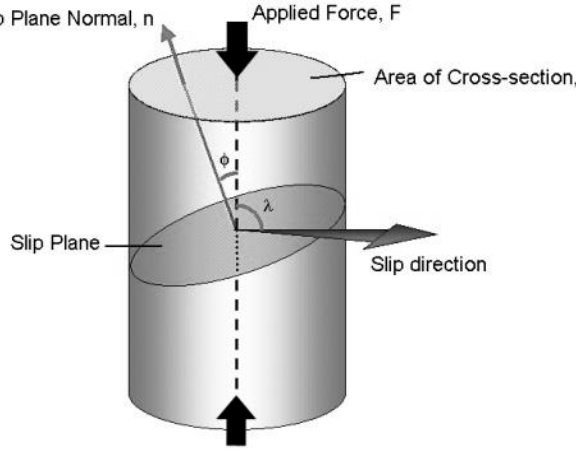
Figure 1. Schematic diagram showing slip mechanism in a single crystal under compressive loading.